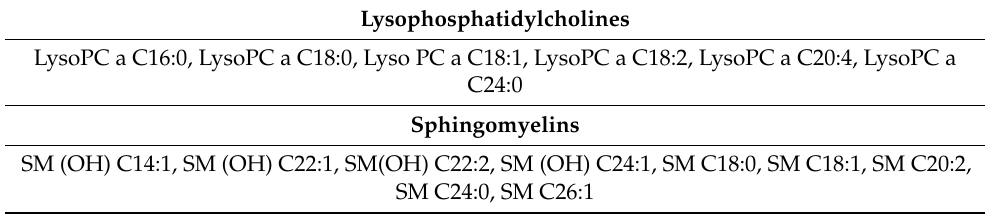
Table 2. Metabolites identified in both targeted and untargeted mass spectrometry